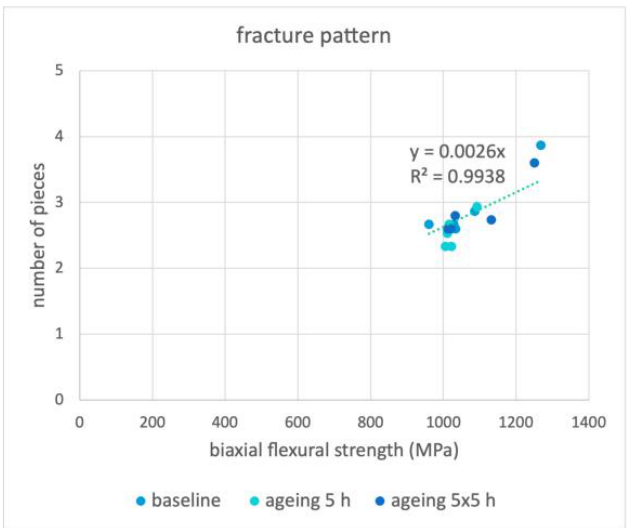
Figure 2. Mean number of fractured pieces correlated to the mean biaxial flexural strength of Zp, Zpt, Zm, Zmt and Z14 for the baseline, ageing 5 h, and ageing 5 × 5 h groups.